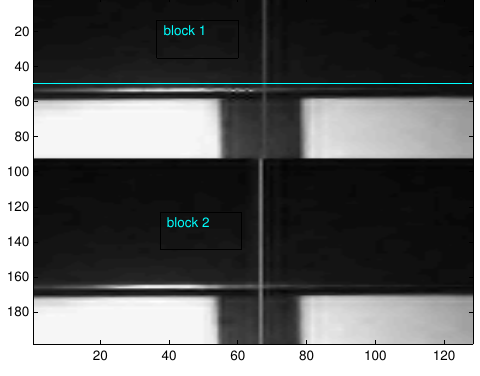
Figure 5. Two blocks in the divided input image.